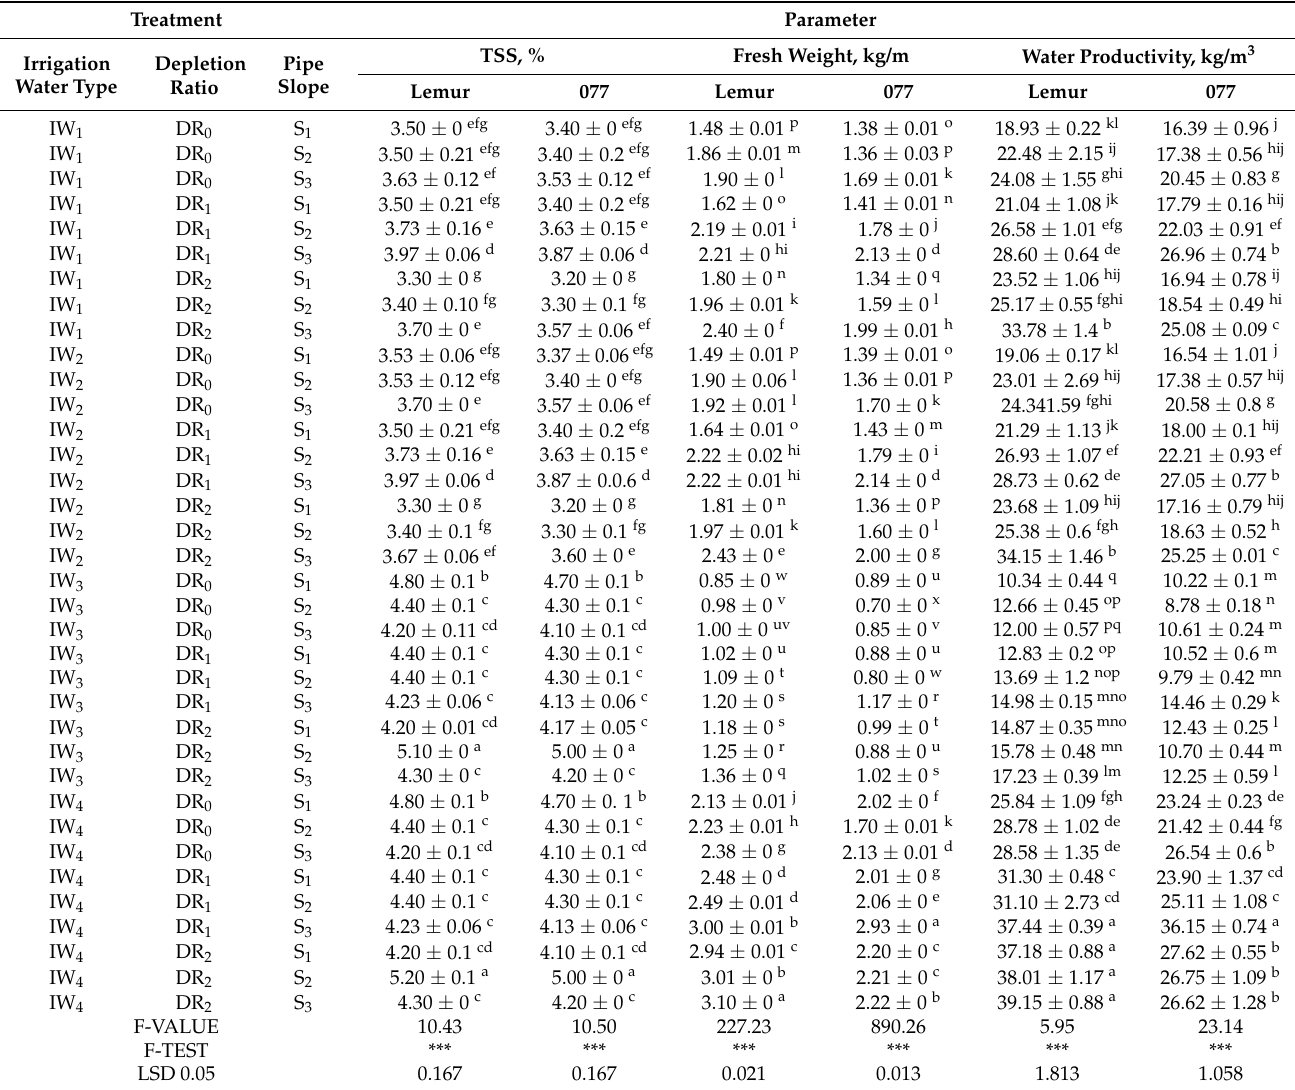
Table 5. Interaction among water type, depletion ratio and pipe slope on total soluble solids, fresh weight and water productivity of both investigated iceberg lettuce